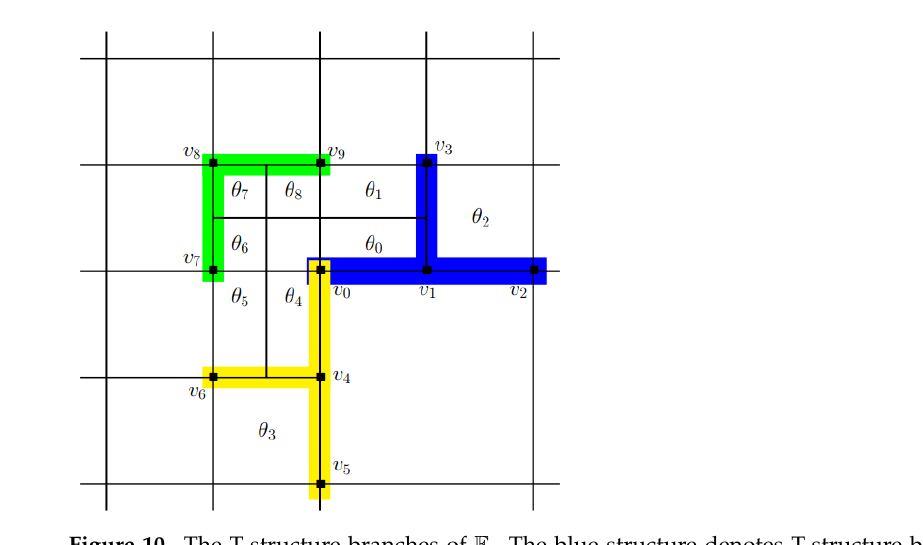
Figure 10. The T-structure-branches of E . The blue structure denotes T-structure-branch that is constituted of T 0 (the c-edge v 0 v 2 and cells adjacent to v 0 v 2 ) and T 1 (the c-edge v 1 v 3 and cells adjacent to v 1 v 3 ); The yellow structure denotes T-structure-branch that is constituted of T 2 (the c-edge v 0 v 5 and cells adjacent to v 0 v 5 ), and T 3 (the c-edge v 4 v 6 and cells adjacent to v 4 v 6 ).; The green structure denotes T-structure-branch that is constituted of T 4 (the c-edge v 7 v 8 and cells adjacent to v 7 v 8 ) and T 5 (the c-edge v 8 v 9 and cells adjacent to v 8 v 9 ).